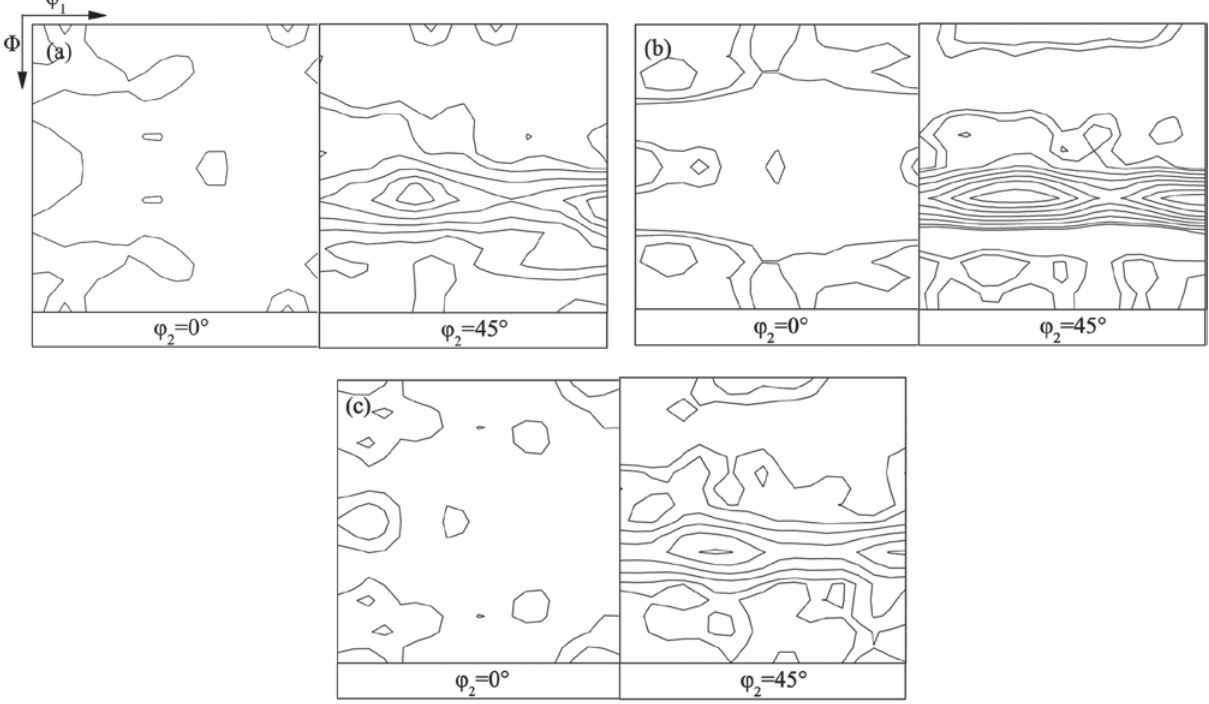
Fig. 8: ODF section views of annealed cold-rolled steel sheets: (a) steel 1; (b) steel 2; (c) steel 3 (levels: 1, 2, 4, 6, 8, 10, 12, 14, 16)